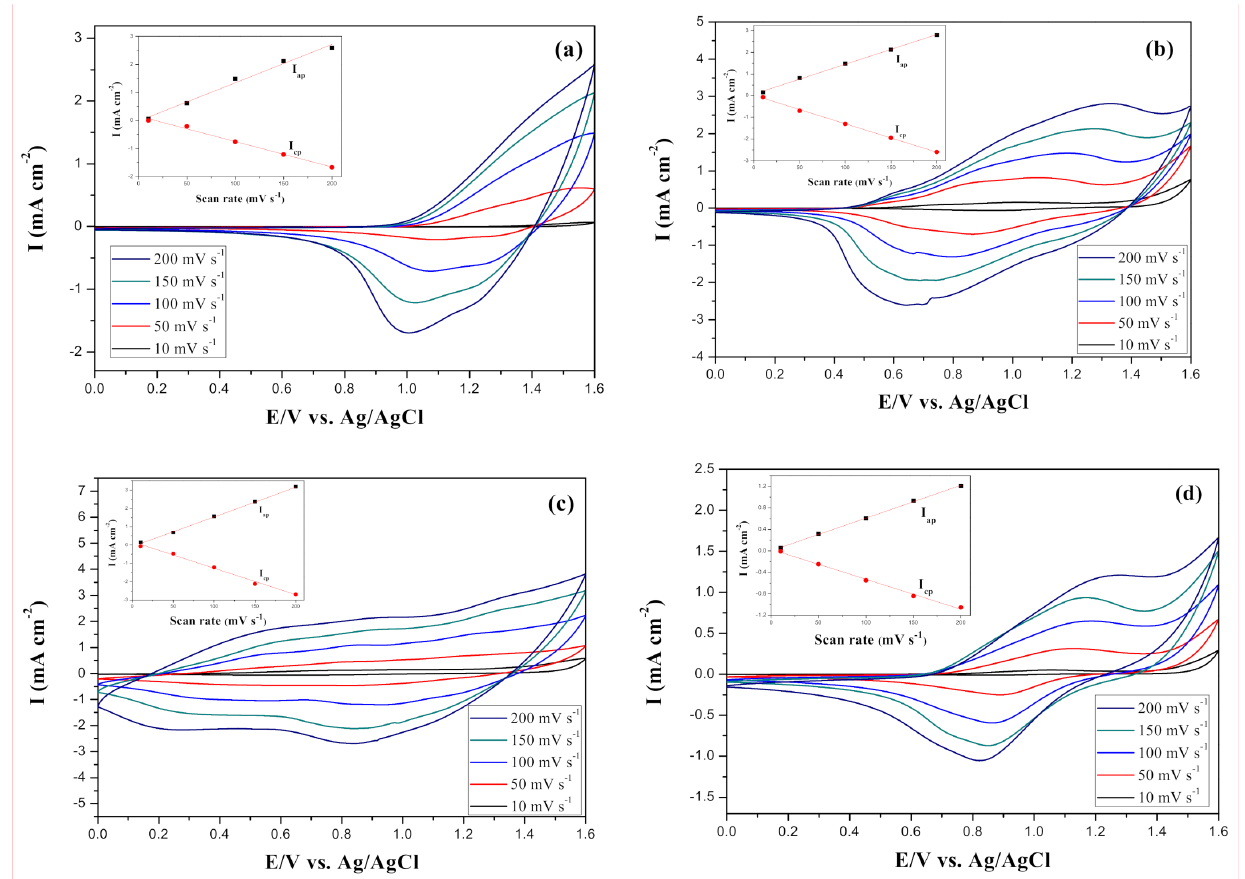
Figure 6. CV curves of ( a ) PBPBC, ( b ) P(BPBC- co -BT), ( c ) P(BPBC- co -CDT), and ( d ) P(BPBC- co -CDTK) films at different scan rates between 10 and 200 mV s − 1 in 0.2 M LiClO 4 of ACN/DCM solution (ACN/DCM = 4:1, by volume). Insets are the scan rate dependence of anodic and cathodic peak current densities of